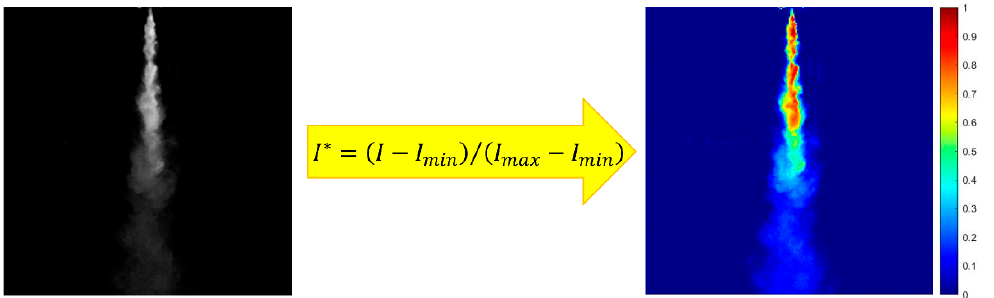
Figure 3. The dimensionless grayscale intensity distribution of the cavitation cloud image after image processing.